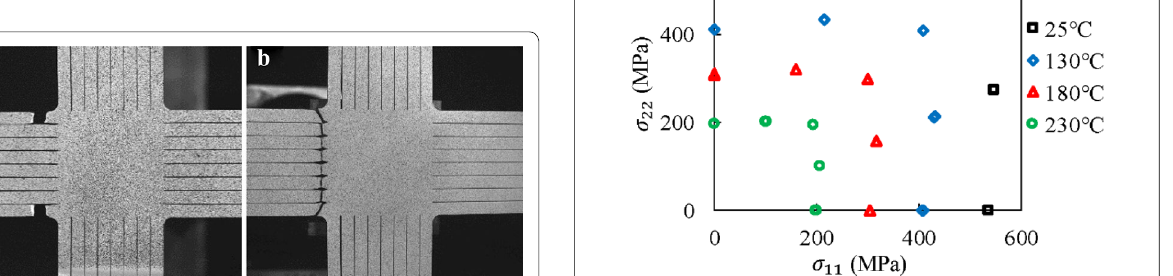
Figure 9 Experimental yield loci with ε p = 0.002 at various